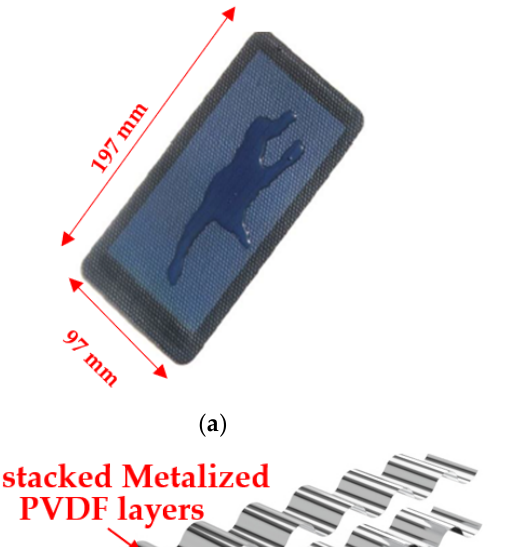
Figure 3. Graphical illustration of the multisource energy harvesting section, which shows the connections between the harvesters and conditioning modules integrated into the garment. Front view ( a ) and rear ( b ) views of the designed garment with highlighted the harvesting section.